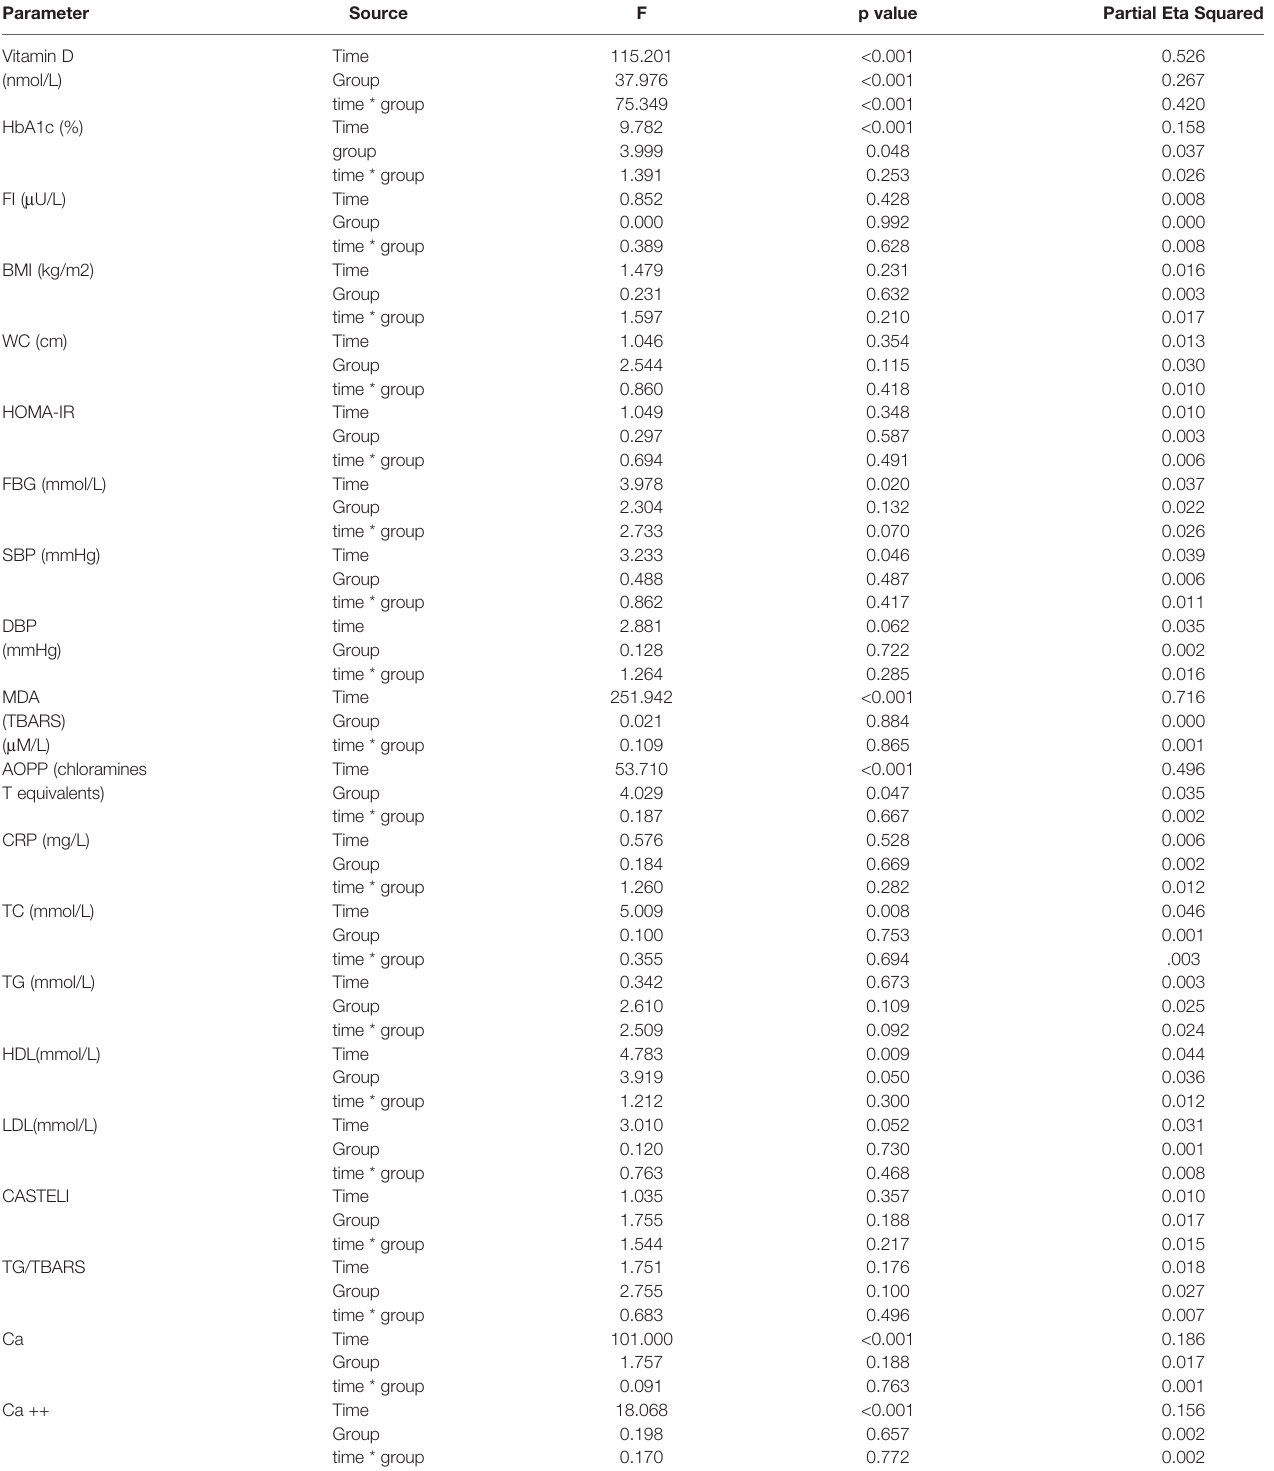
TABLE 3 | Results of two-way ANOVA for effects of the Time factor and Group factor in the study.